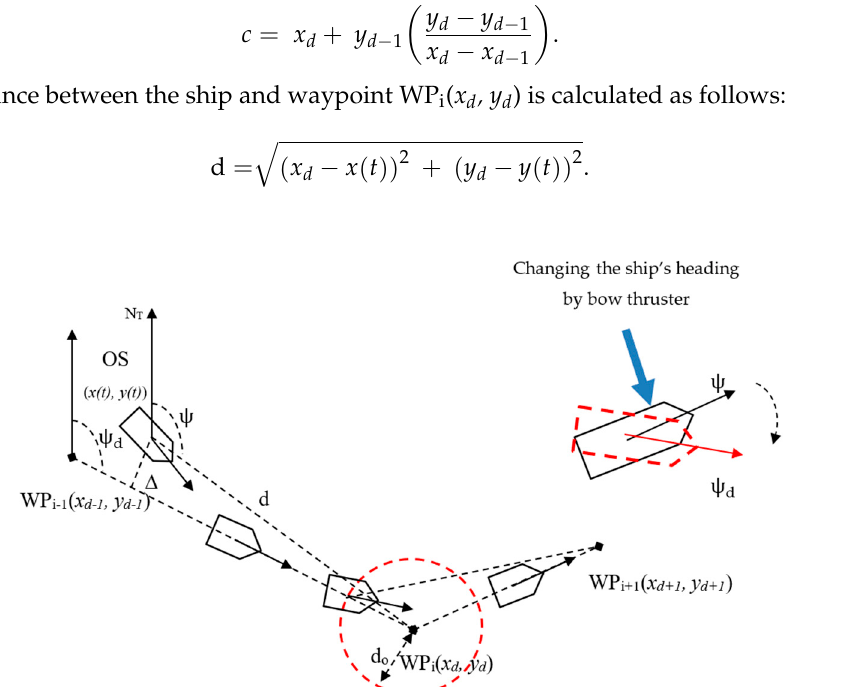
Figure 5. The heading angle from ship to waypoint.